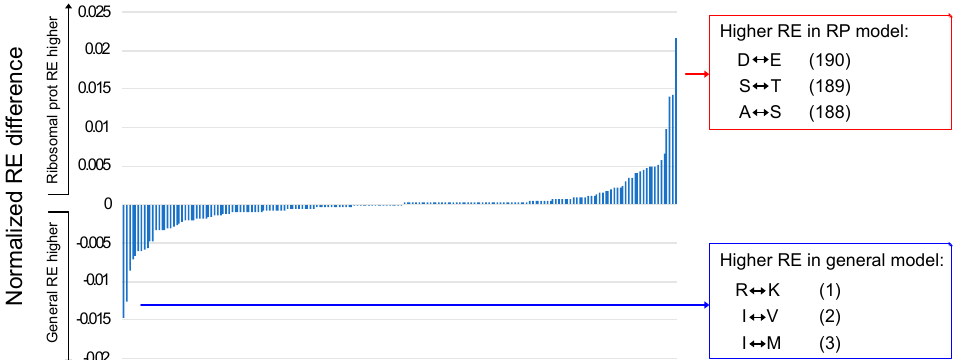
Figure 3. Comparison of REs for ribosomal protein models and general models. The normalized averages of the REs for general models were subtracted from REs for ribosomal protein models and sorted in ascending order. Large negative values correspond to higher REs in general models, and large positive values correspond to higher REs in the ribosomal protein models. The parenthetical numbers after each exchange correspond to the rank order of the differences when the RE differences are sorted from smallest to largest (i.e., 1 is the RE that was most elevated in the average general model relative to the average ribosomal protein model, 2 is the second most elevated, and so forth until 190, which are the REs that were most elevated in the average ribosomal protein model relative to the average general model). All RE estimates are available in Supplementary File S5.